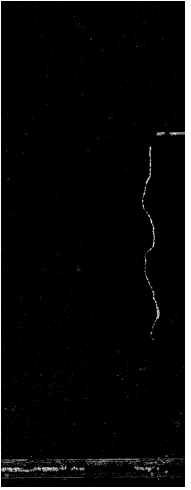
Figure 12. Change map fusion by